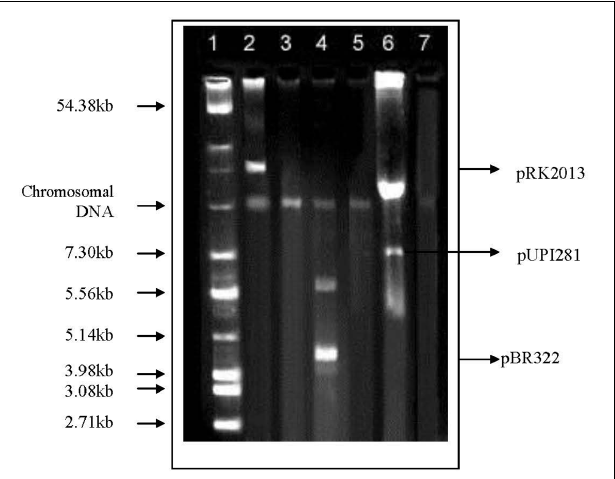
FIGURE 2 | Agarose gel electrophoresis of plasmid DNA in standard strains as well as clinical isolates harboring R-plasmids and their cured derivatives. Lane 1, Reference plasmids from E. coli MTCC 131; Lane 2, E. coli MTCC398 (pRK2013); Lane 3, Cured derivative of E. coli MTCC398; Lane 4, E. coli K12 (pBR322); Lane 5, Cured derivative of E. coli K12; Lane 6, Ac. baumannii A24 (pUPI281); Lane 7, Cured derivative of Ac. baumannii